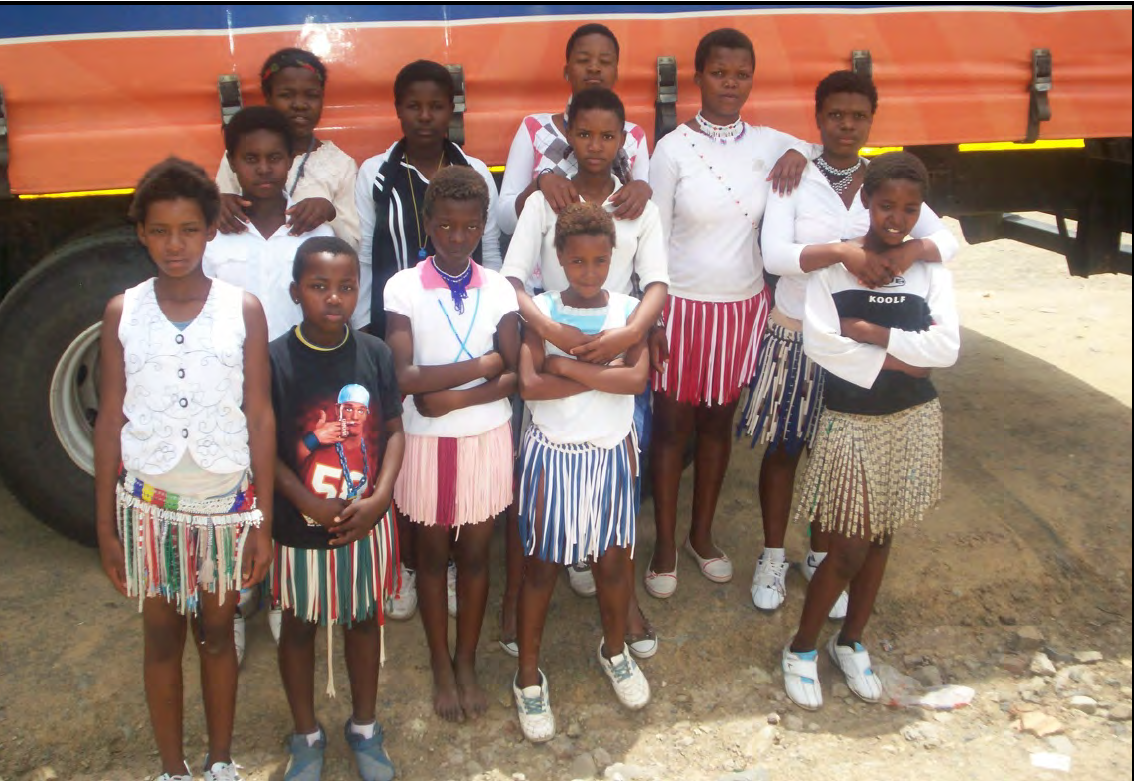
Figure 2: Mamtiseni initiates display their attire Studies on initiation ceremonies from other ethnic groups within South Africa and beyond conducted by scholars such as Soga (1931), Laubscher (1975), Richards (1956), Hunter (1961), Hansen (1981), Dargie (1988), Levine (2005) Dontsa (2007) and Lumbwe (2009), among others, indicate that as much as these initiation ceremonies continue to be practised, some elements disappear completely, some undergo change, while others survive and continue in their traditional